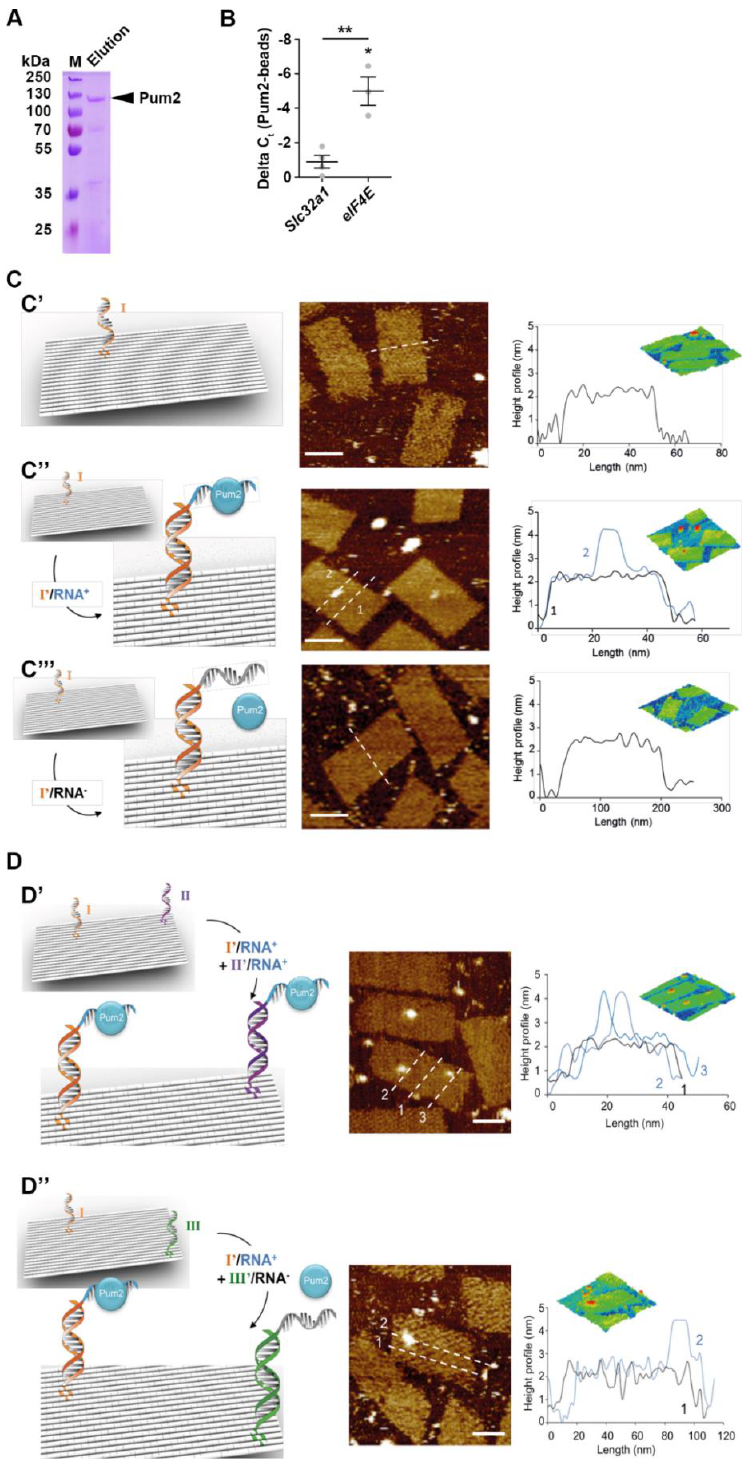
Figure 4. Atomic force microscopy reveals Pum2 binding to eIF4E mRNA. ( A ) Coomassie-stained SDS-gel upon Nickel-NTA purification of His 6 -tagged full length Pum2. ( B ) Relative enrichment of eIF4E and Slc32a1 mRNA in His 6 -tagged full length Pum2 pulldown. ( C , D ) Scheme for AFM experimental setup ( left ), representative AFM images ( middle ), and height profiles ( right ) for Pum2 particles bound to immobilized eIF4E 3′ -UTR RNA probes. See text for explanations. P -values were calculated using one-sample t -test within samples and unpaired Students t -test between samples. * p < 0.05, ** p < 0.01, 4 biological replicates.